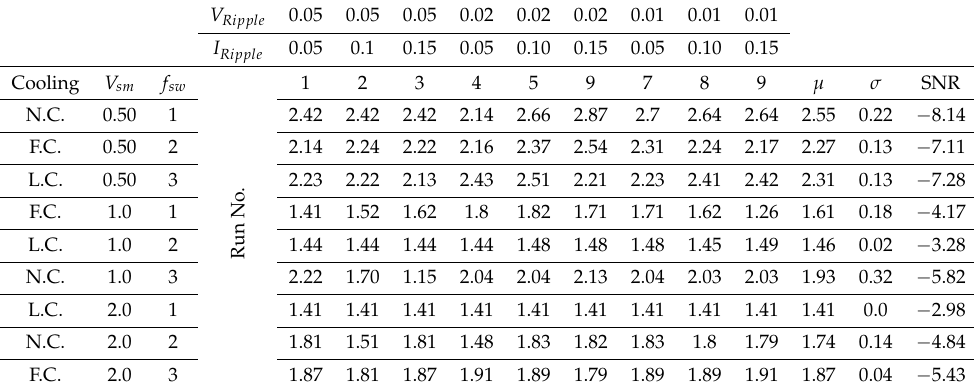
Table 2. Taguchi orthogonal array for MMC showing volume in m 3 .